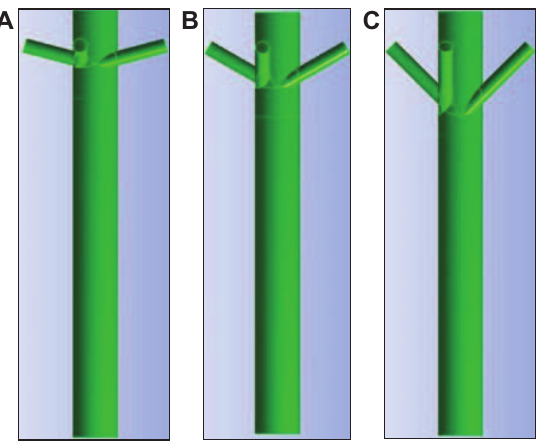
Figure 4 Injector angles of (A) 15 ° , (B) 30 ° and (C) 45 ° .